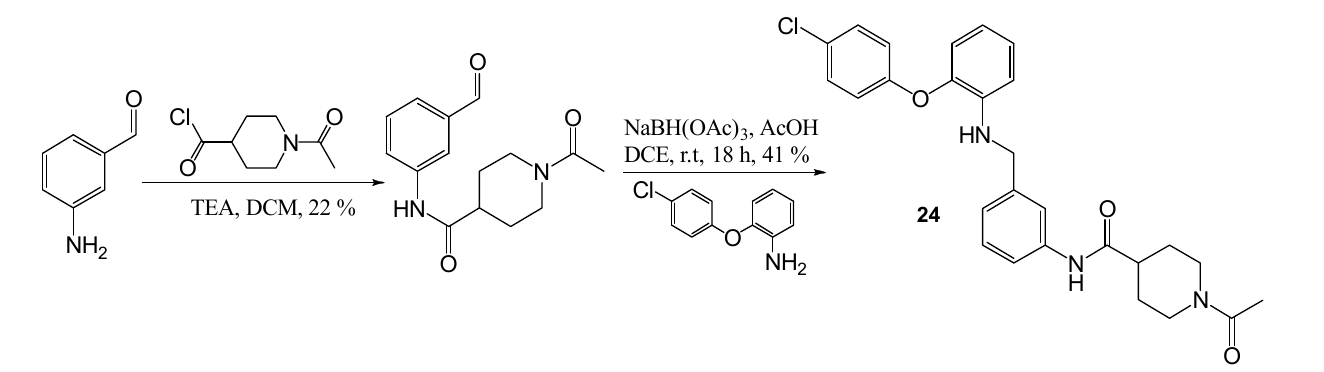
Table 4. Biological results obtained for the extended analogues; a results obtained from the TLC assay. Mean of at least 2 measurements with typically an SD of ± 5%. b Not determined.